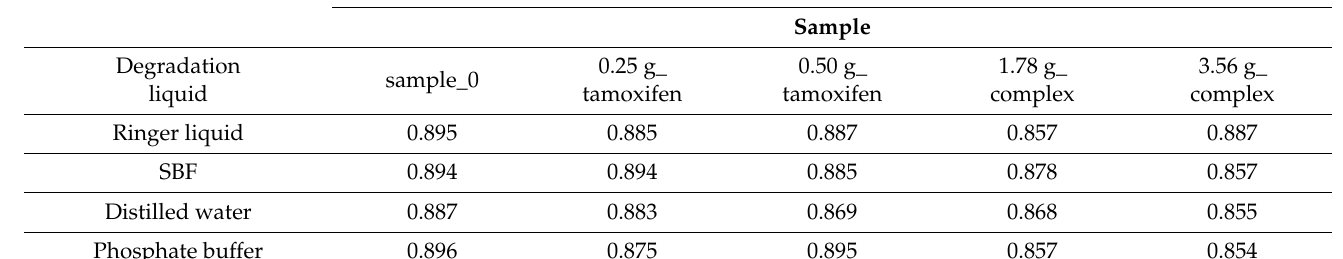
Table 5. Masses of samples verified during their incubation in physiological liquids .